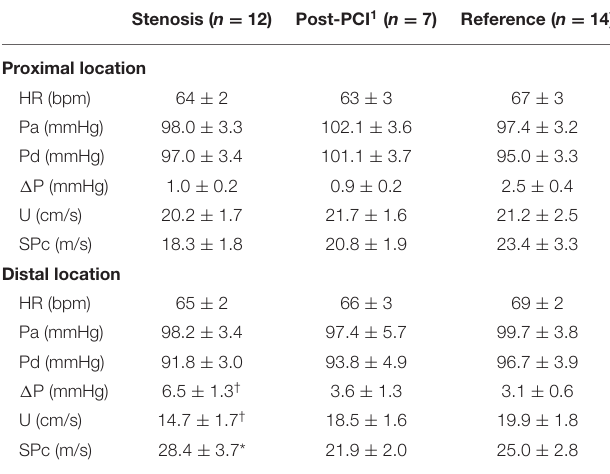
TABLE 2 | Coronary hemodynamics and wave speed.